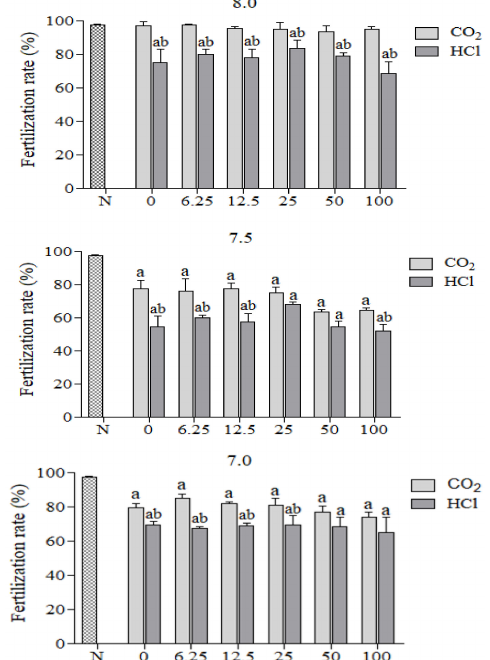
Figure 3. Perna perna fertilization rate results obtained after exposure to different concentrations of CC and acidification at different pH values 8.0, 7.5, 7.0 promoted by CO 2 and HCl supplies. Concentration 0 means acidified but with no CC. A statistically significant difference ( p < 0.05) compared with N (reconstituted seawater considered as negative control) is shown with “a”; and between CC concentrations in different acidified methods is shown with